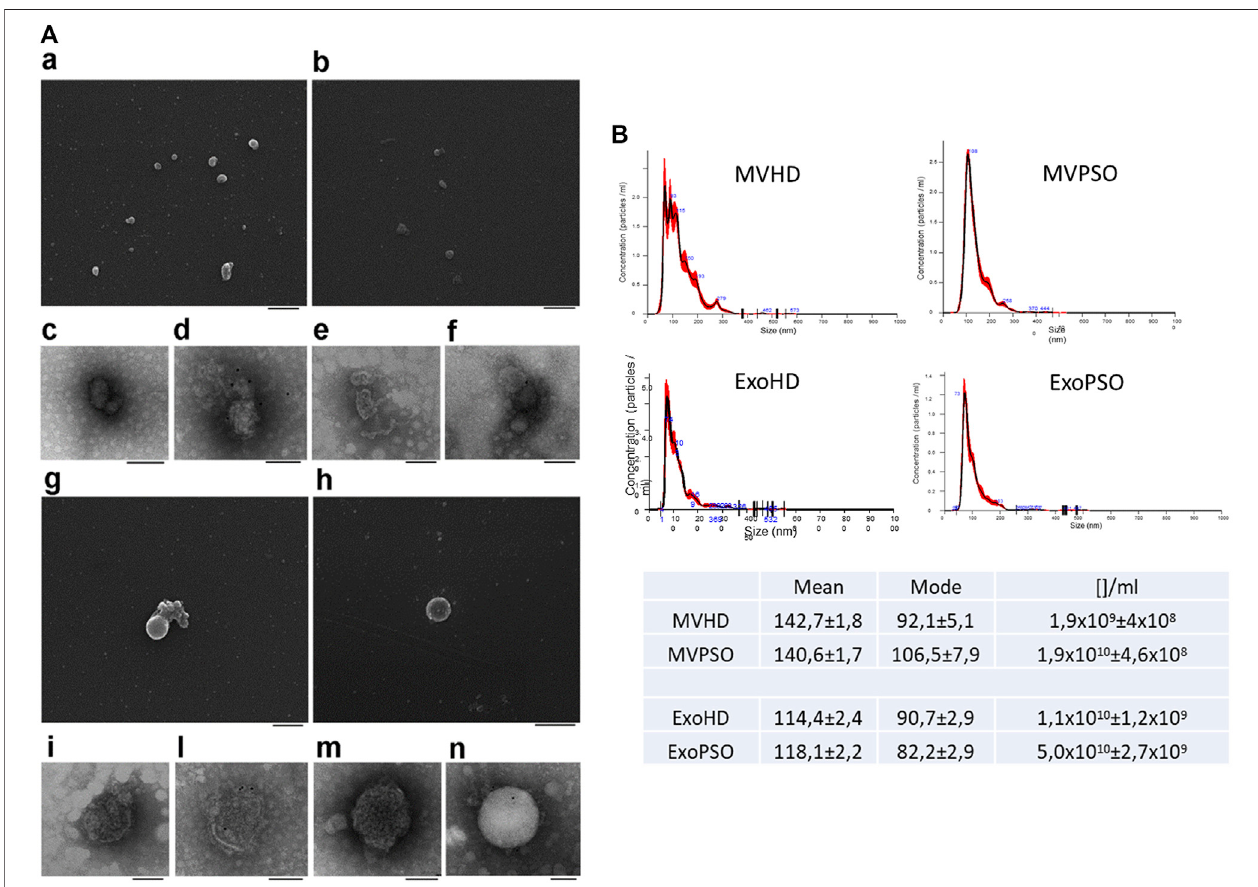
FIGURE 1 | Morphological characterization of MV and Exo from plasma of HD and PSO. (A) . Scanning electron microscopy analysis of MVHD (a) and ExoHD (b) , Bars 500 nm.Transmissionelectron microscopyanalysisofMVHD (c) and ExoHD (e) , Bars200 nm.CD81-Immunoelectron microscopy ofMVHD (d) and inExoHD (f) , Bars 100 nm. Scanning electron microscopy analysis of MVPSO (g) and ExoPSO (h) , Bars 500 nm. Transmission electron microscopy analysis of MVPSO (i) and ExoPSO (m) ,Bars200 nm.CD81-ImmunoelectronmicroscopyofMVPSO (l) andinExoPSO (n) ,Bars100 nm. (B) Nanoparticletrackinganalysis(NTA)analysisof MVHDandMVPSO(upperpanels)andExoHDandExoPSO(lowerpanels).Representativespectraareshown.Mean,mode,andparticlesnumber/ml([]/ml)arereported in the Table.